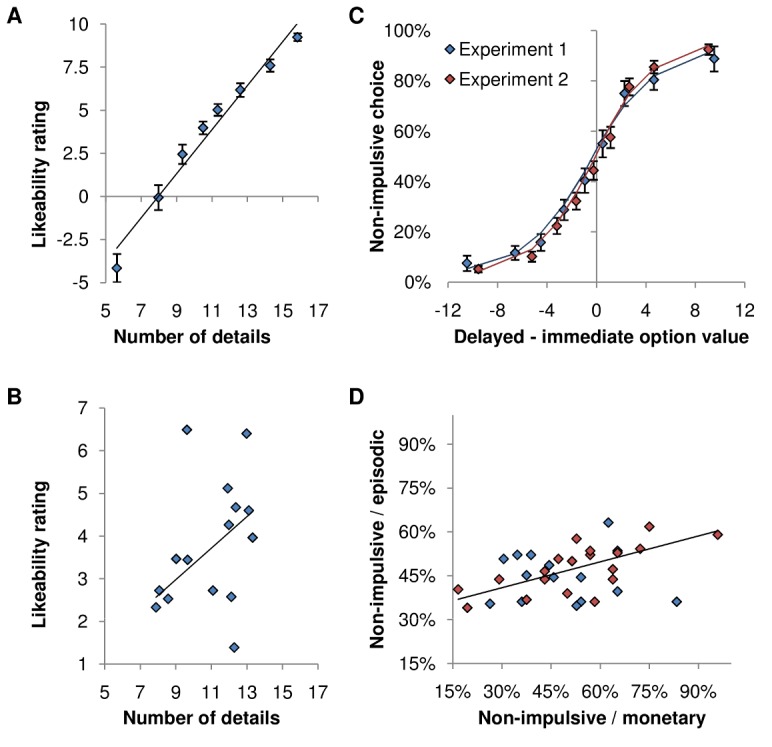
Behavioral analysis.Left: Correlation between likeability rating and simulation richness (number of details reported per option). (A) Correlation across trials (data were binned into eight data points). (B) Correlation across participants (each dot is one subject). Right: Analysis of nonimpulsive choice rate (preference for the delayed option). (C) Nonimpulsive choice rate as a function of the difference in value estimates between immediate and delayed options. Differential values were individually calculated using hyperbolic discounting for every option, then binned into nine data points and averaged across subjects. Solid lines indicate model estimates using a softmax decision rule. (D) Intersubject correlation of nonimpulsive choice rate between monetary and episodic tasks. In all scatter plots, lines represent robust regression fits. In all panels blue and red diamonds represent data from Experiments 1 and 2. Error bars indicate intersubject standard errors of the mean.